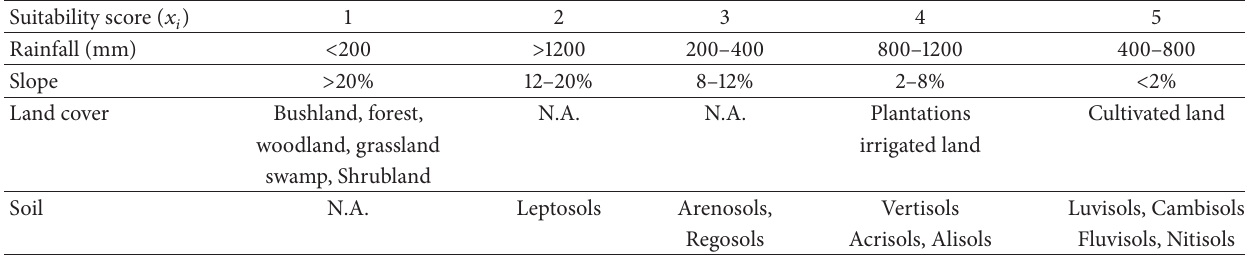
Table 2: Suitability classes of different constraint factors used to identify suitable areas for water harvesting schemes using MCE weighted overlay technique.